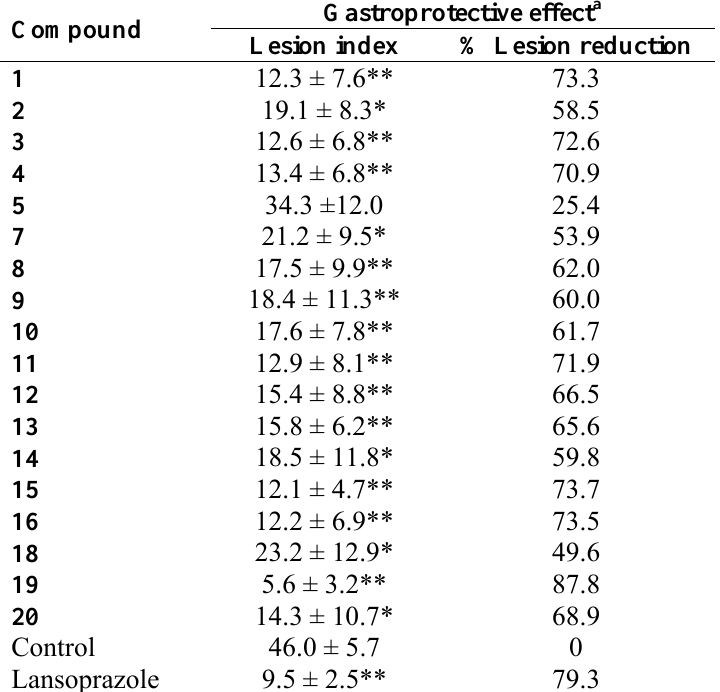
Table 1. Gastroprotective effect of the compounds 1 - 5 , 7 - 16 , 18 - 20 at 25 mg/kg on the HCl/EtOH induced gastric lesion model in